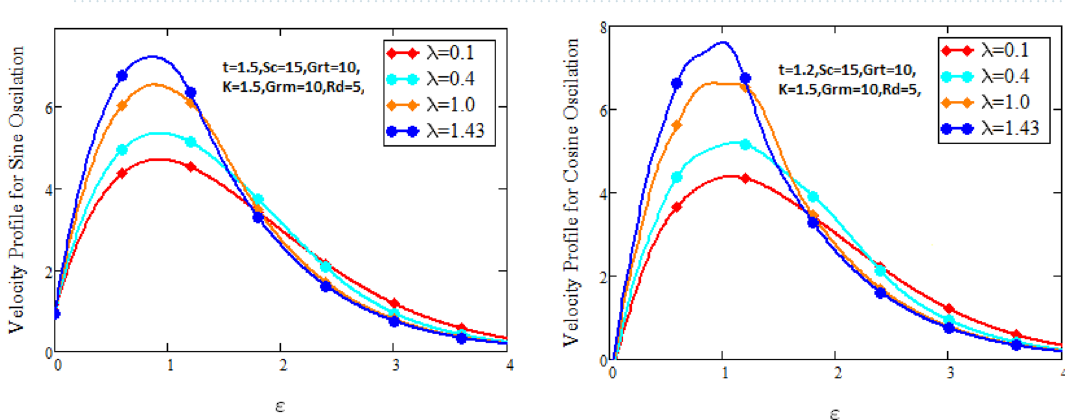
Figure 7. Velocity curves for various values of K .